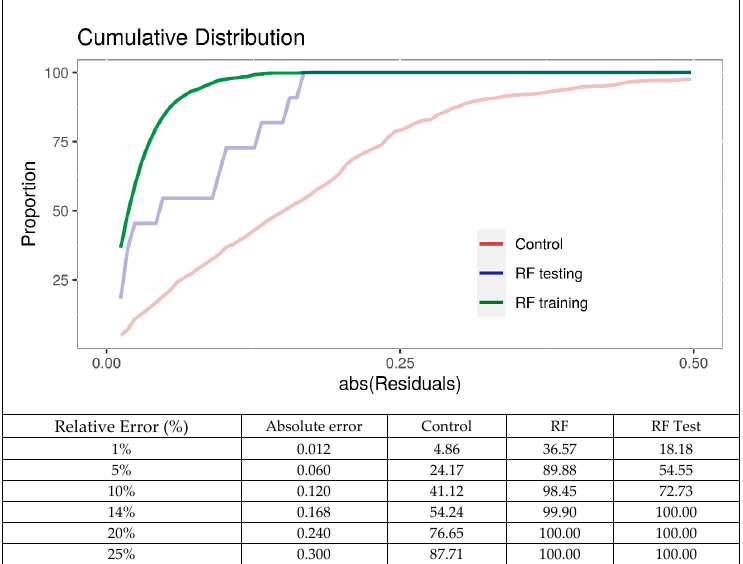
Figure 7. Model performance indicators.